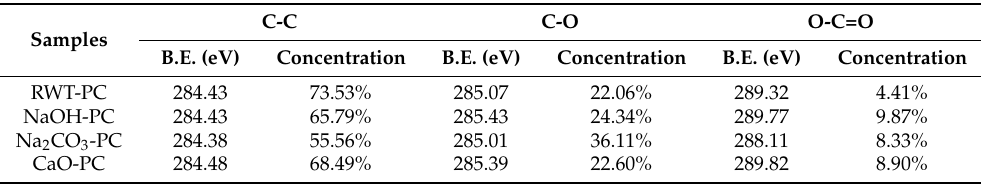
Figure 3. ( a ) Complete X-ray photoelectron spectroscopy (XPS) scan of pyrolytic chars and ( b ) C1s spectrum. Table 2. The relative content of the surface functional groups is determined by C1s of various pyrolytic